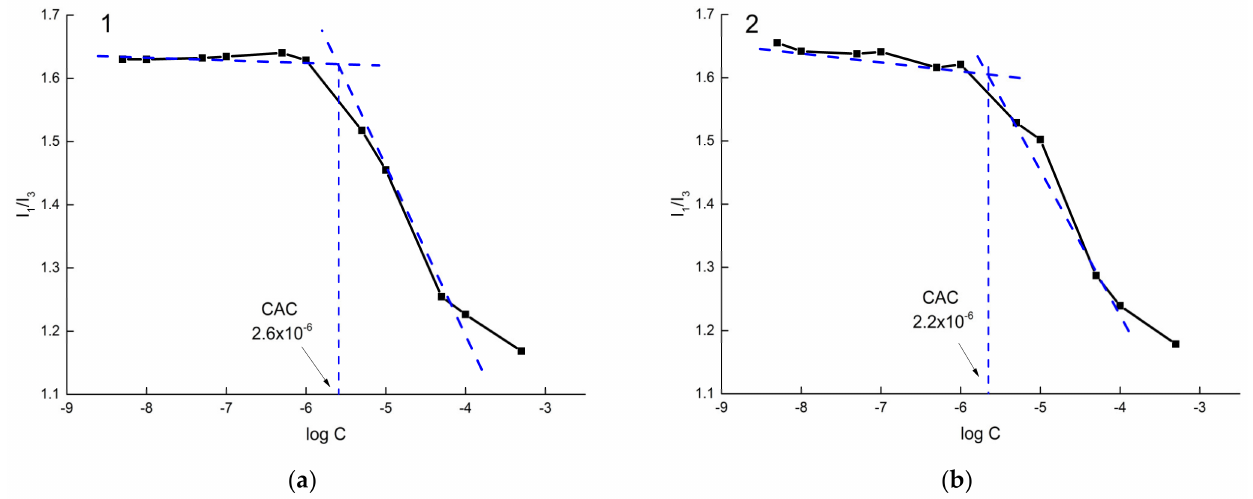
Figure 4. CAC determination for HC 1 ( a ) and HC 2 ( b ) amphiphilic polyelectrolyte copolymers in